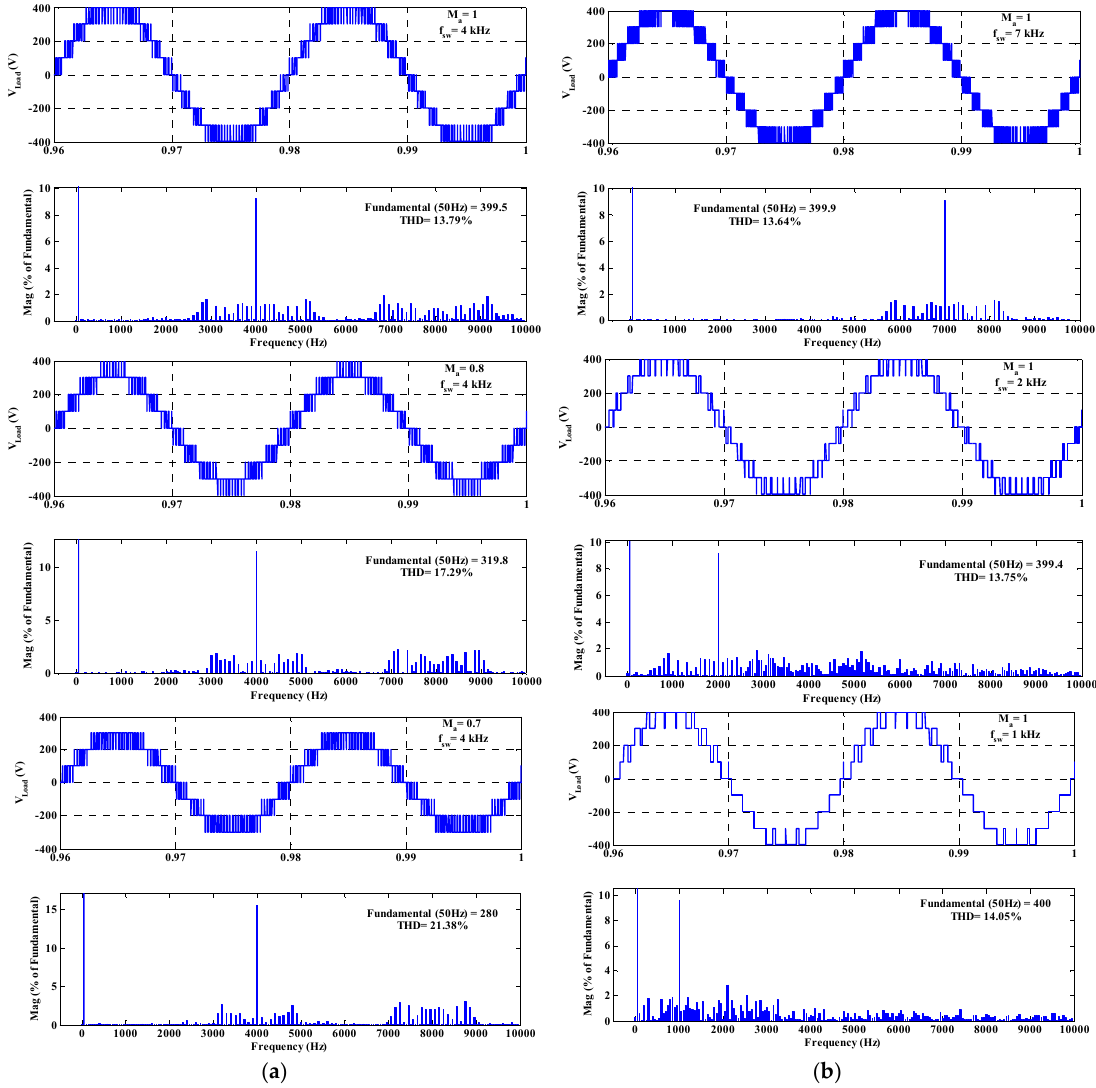
Figure 10. The effect of ( a ) modulation index on the V Load , ( b ) switching frequency on the V Load . To validate the high performance of the proposed model, a low-power prototype of the proposed inverter has been implemented and tested. Accordingly, a Texas Instruments (TMS320F28335) fixed-point DSP control board generated gate pulses for employed switches (IRFP460 500 V/ 20 A). Moreover, the value of capacitances and input DC source are selected at 2300 µF and 140 V, respectively. Figure 11 illustrates the results obtained from the hardware implementation of the proposed inverter model under steady-state and transient operating conditions. These figures fully confirm the flawless performance of the proposed inverter.